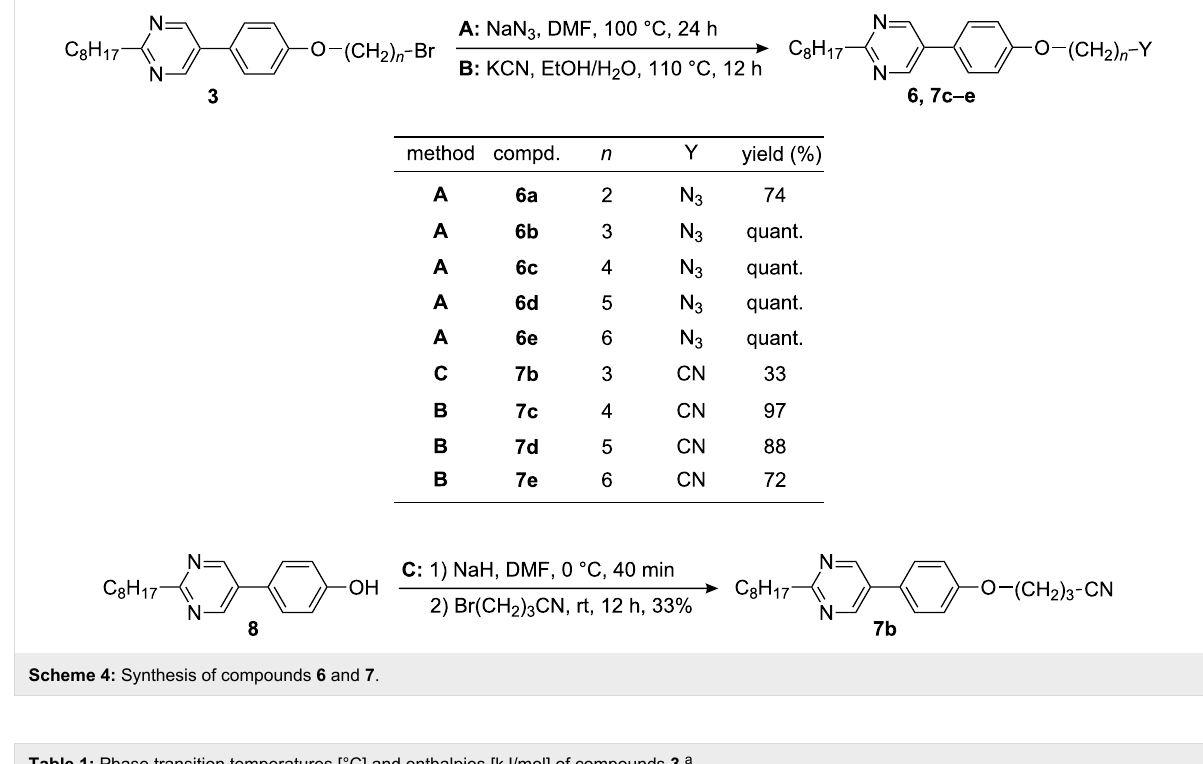
Table 1: Phase transition temperatures [°C] and enthalpies [kJ/mol] of compounds 3 .